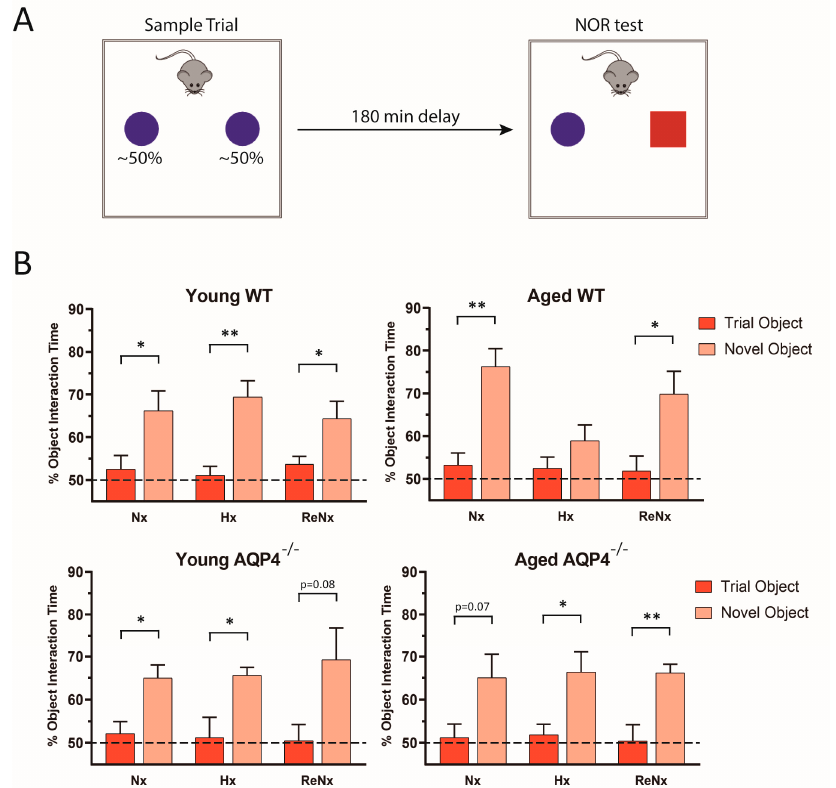
Figure 2. Re-normoxic treatment recovers the cognitive deficit induced by hypoxia in aged wt mice. ( A ) Illustration showing the experimental protocol performed to evaluate cognitive function, by novel object recognition (NOR) test. ( B )The NOR assessment was performed in wt or AQP4 -/- , young and aged, mice subjected to normoxia (Nx), hypoxia (Hx), or re-normoxia (ReNx). The analysis represents the interaction time (in percentage, %) the mice spent with the new object compared with the old one, for each experimental group. Dashed lines at 50% of the object interaction time indicates the expected time of interaction for both identical objects during the sample trial. Data are represented as mean ± SEM. Number of animals analyzed for each experimental condition: Young-wt, Nx ( n = 12); Hx ( n = 9); ReNx ( n = 8). Aged-wt, Nx ( n = 9); Hx ( n = 10); ReNx ( n = 9). Young-AQP4 -/- , Nx ( n = 9); Hx ( n = 9); ReNx ( n = 5). Aged-AQP4 -/- , Nx ( n = 6); Hx ( n = 8); ReNx ( n = 8). * p < 0.05; ** p < 0.01.